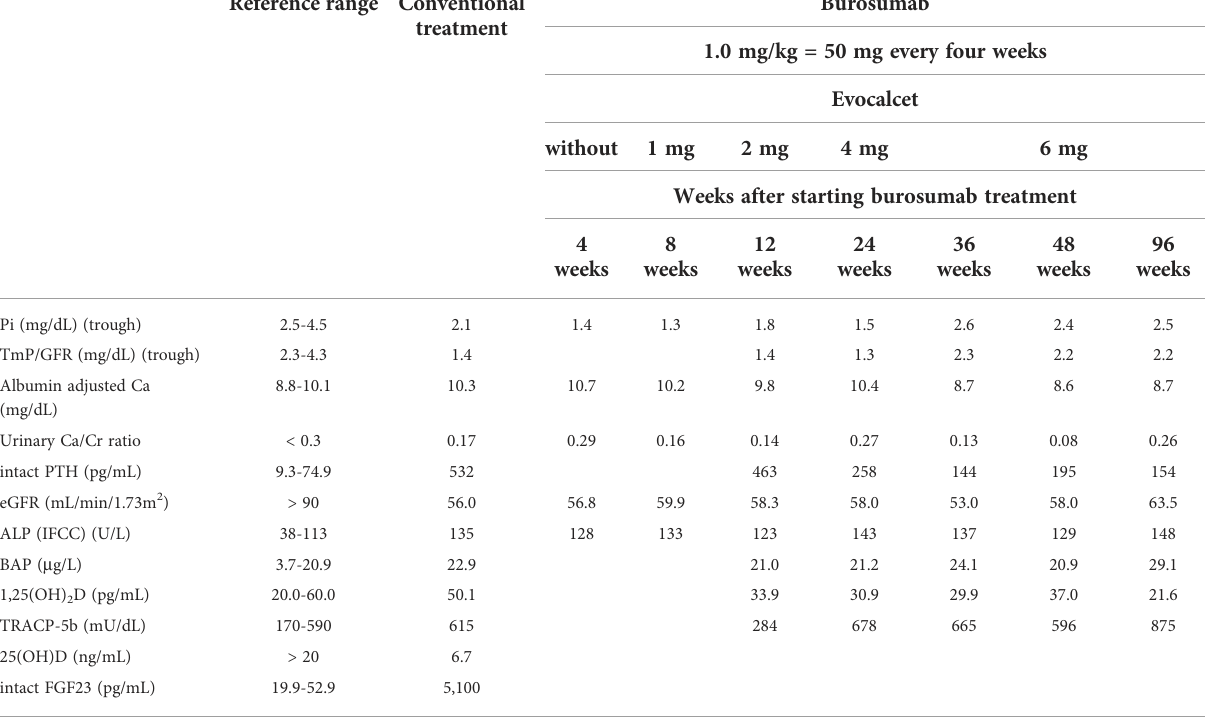
TABLE 1 The changes in each parameter after starting burosumab treatment.